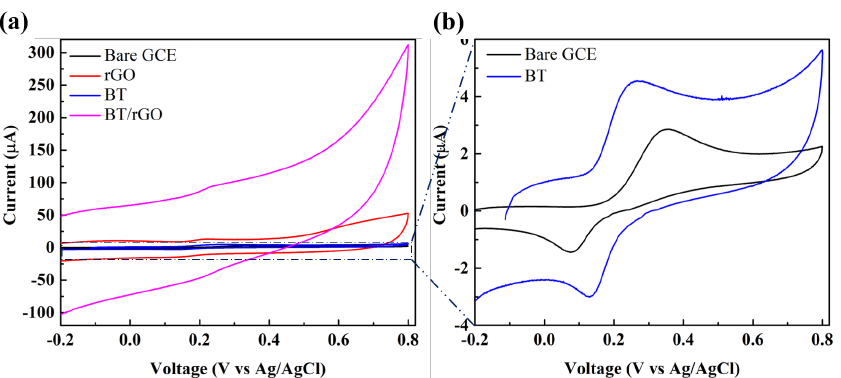
Figure 6. CV profiles of dopamine (100 µM) obtained using PBS (0.1 M) at a scan rate of 100 mV/s with ( a ) bare GCE, rGO, BT, and BT/rGO. ( b ) Magnified view of the bare GCE and BT electrode